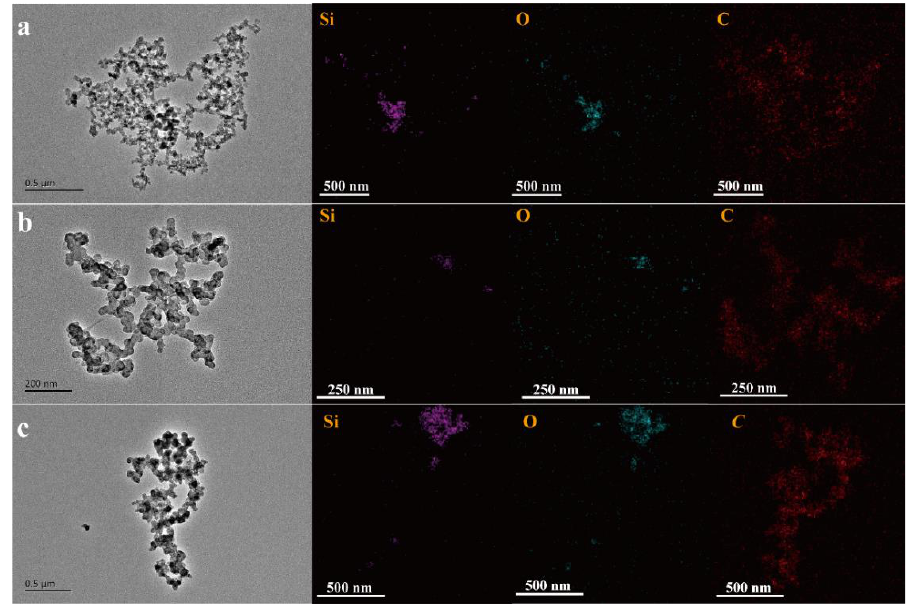
Figure 2. TEM and elemental mapping images of silica aerogels mixed with KB ( a ), SP ( b ), and AB ( c ).